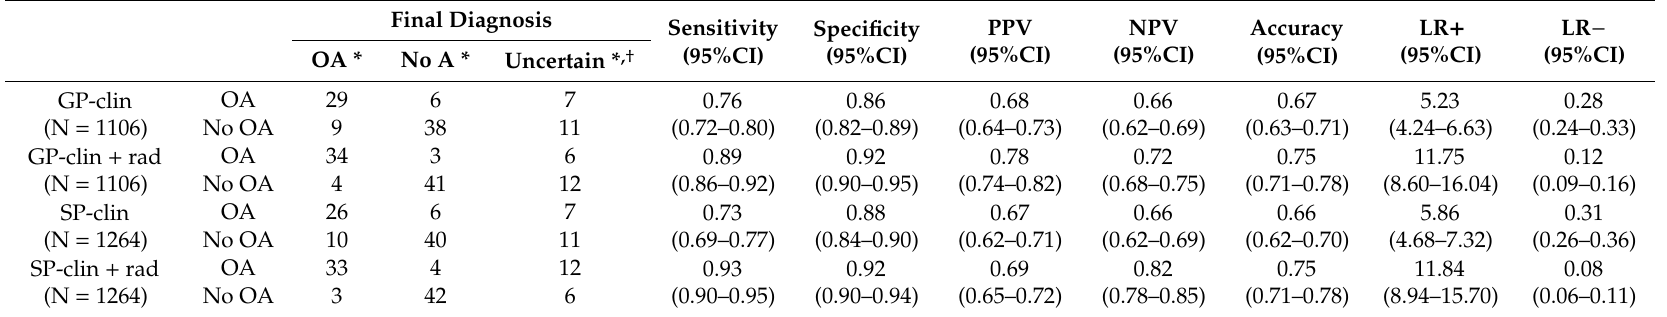
Table 3. Comparison of initial and consensus-based final